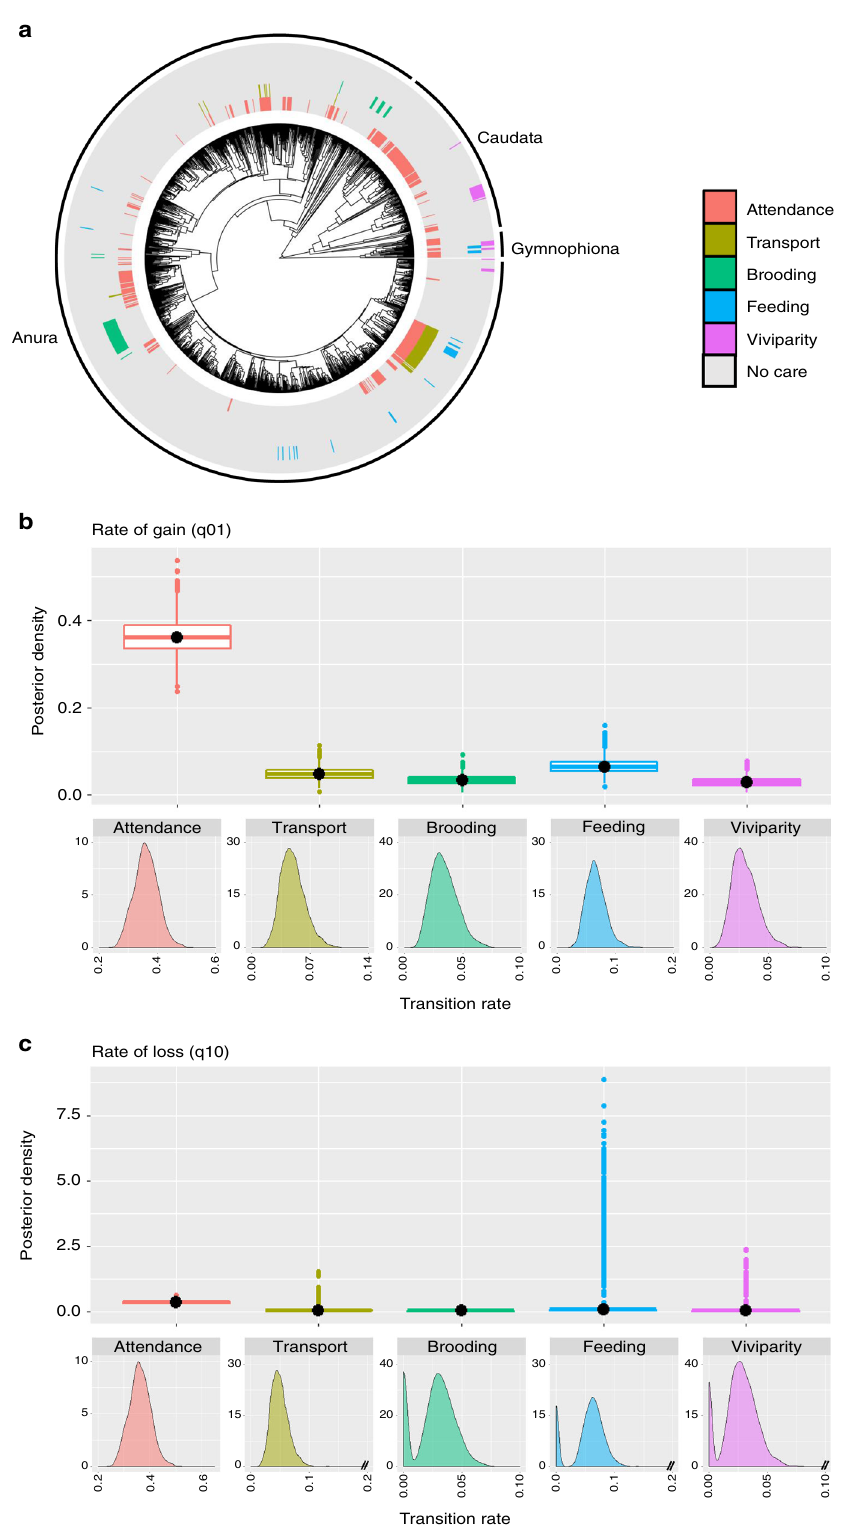
Fig. 2 Evolutionary history of amphibian parental care grouped according to function. a Distribution of parental care forms in amphibians ( n = 1322), grouped according to function (i.e. attendance, transport, brooding, feeding and viviparity) irrespective of stage of development at which they occur (sample sizes by function in Supplementary Table 1b). The posterior distributions of the RJ Multistate transitions for the b rates of gain (q 01 ) and c rates of loss (q 10 ) of each care form are shown as box plots for comparison, and as posterior density plots for each care form alone. The central black dot in the box plots indicates the median, the box the upper and lower quartiles, the vertical lines the 95% credible intervals of the posterior distributions, and the fi lled dots beyond the lines indicate outlier estimates. Care forms are coded with the same colours across all